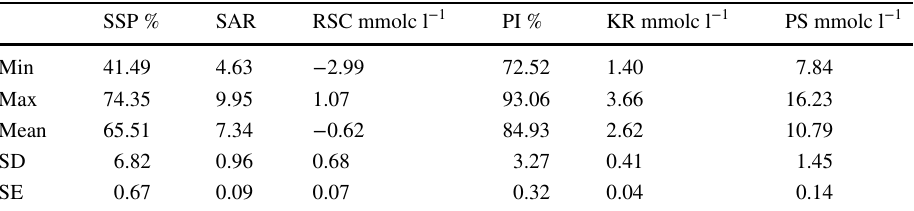
Table 3 Summary of the water quality